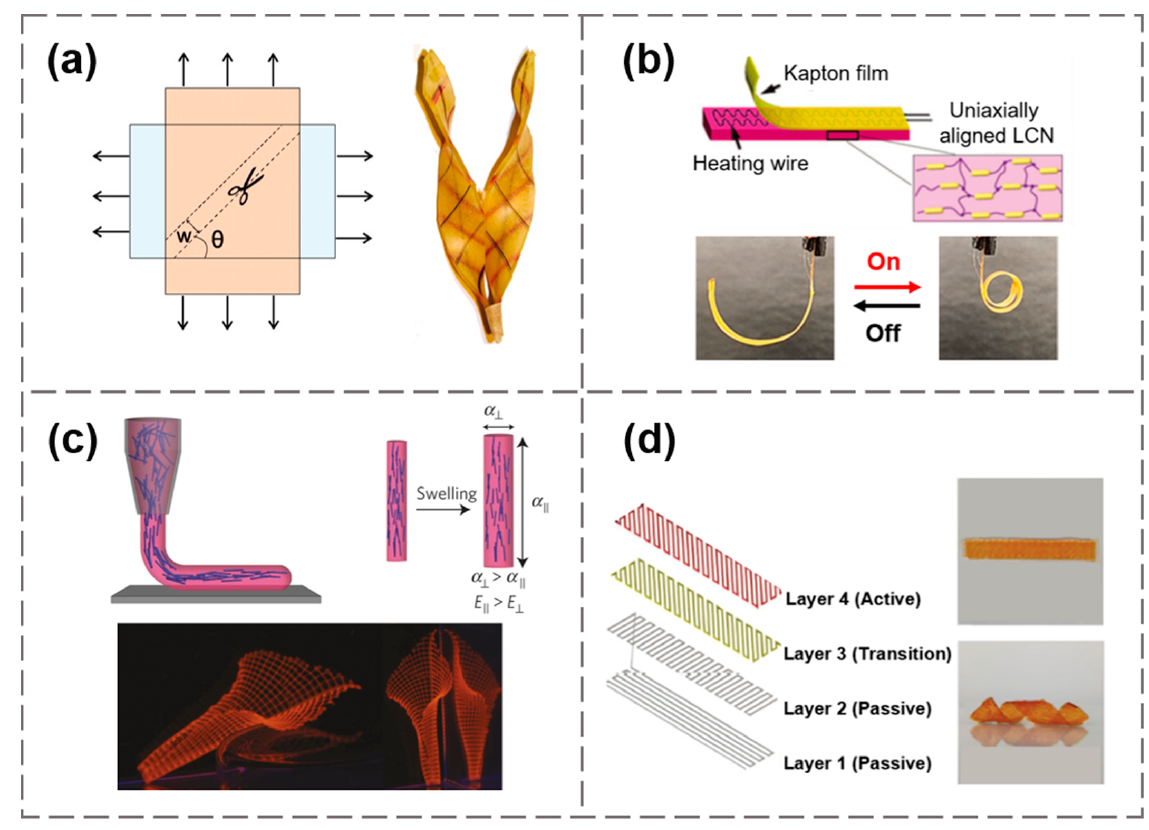
Figure 5. ( a ) A pre-stretching induced pod-like chiral shape. Reproduced from Ref. [84]; ( b ) An LCE rolled-up actuator. Reproduced from Ref. [60]; ( c ) Biomimetic structures printed by anisotropic hydrogel filaments. Reproduced from Ref. [9]; ( d ) Helical shape generated by different alignments of active gel fibers in a hydrogel composite. Reproduced from Ref. [61].